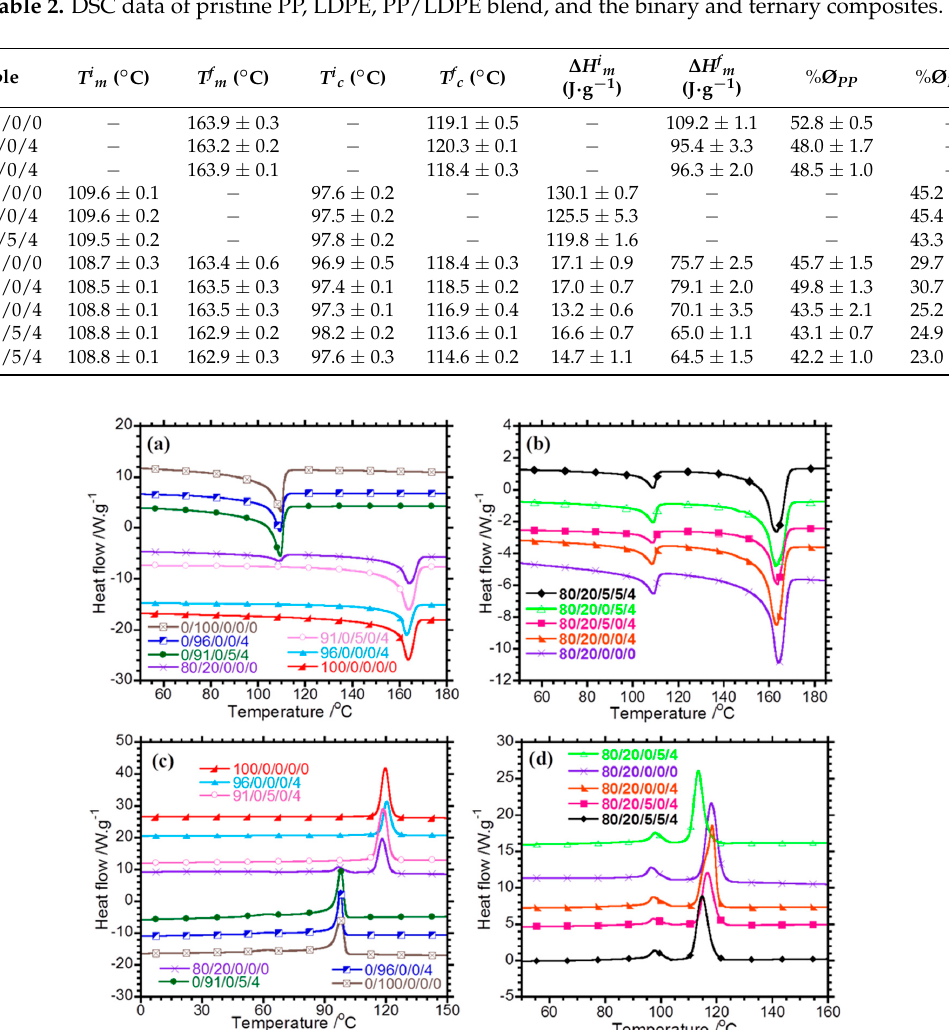
Figure 1. ( a , b ) Melting and ( c , d ) cooling curves of the neat polymers, blend, and composites.